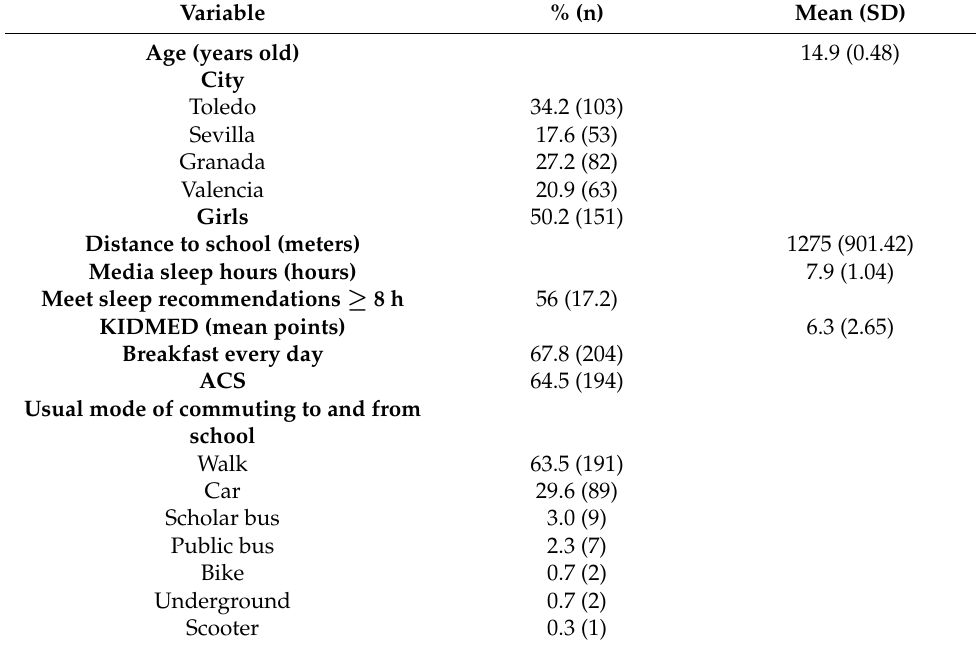
Table 1. Participant